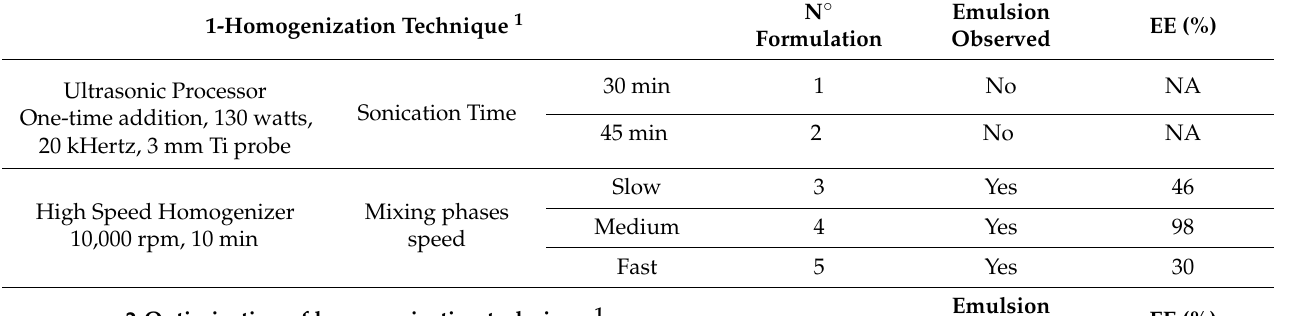
Table 1. Parameters and conditions tested in the development and optimization of the